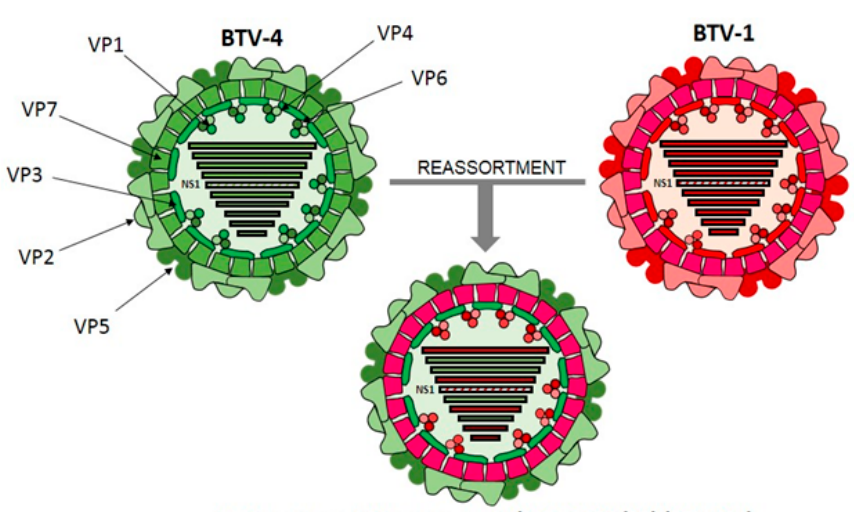
Figure 1. Schematic representation of BTV-4 Morocco, a bluetongue virus (BTV) strain generated as a consequence of a reassortment event between BTV-4 and BTV-1 serotypes. Three concentric protein layers constituted by VP2 and VP5 (outer capsid), VP7 (intermediate layer) and VP3 (subcore), are depicted. Structural proteins VP1, VP4 and VP6 are located inside the inner capsid constituting the RNA polymerase complex. Double-strand RNA segments 1 (VP1), 4 (VP4), 5 (NS1), 7 (VP7), 9 (VP6 and NS4) and 10 (NS3/NS3A and NS5), deriving from BTV-1, are represented in red. Double-strand RNA segments 2 (VP2), 3 (VP3), 6 (VP5) and 8 (NS2), deriving from BTV-4, are colored green. BTV dsRNA segment 5, encoding for NS1, is striped.